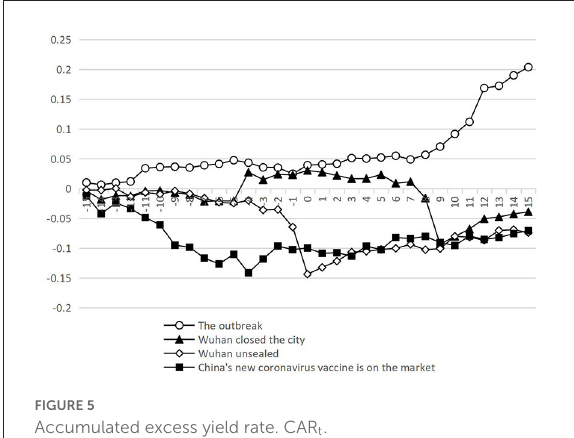
FIGURE5 Accumulated excess yield rate. CAR t